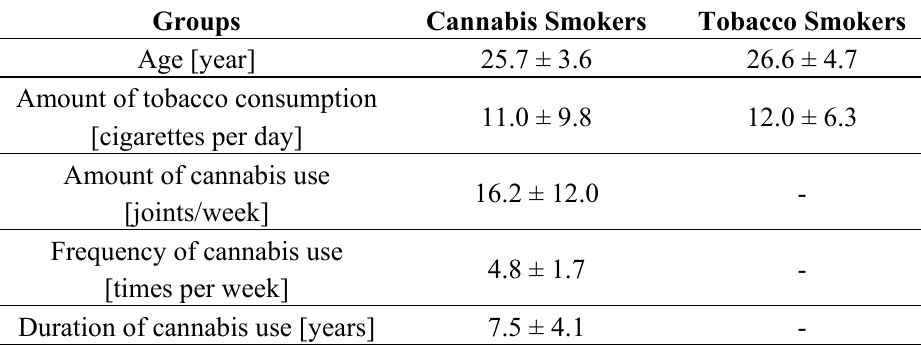
Table 2. Characteristics of the study